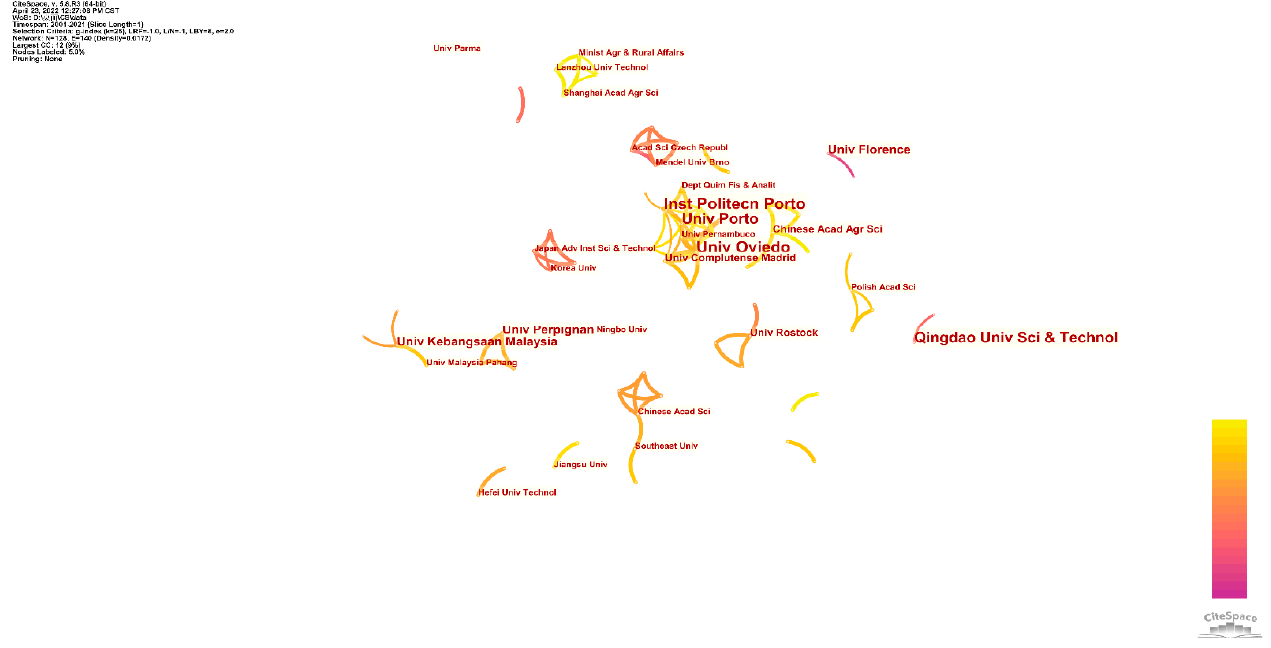
Figure 7. Institution cooperation network of published papers for electrochemical techniques for the detection and analysis of GM crops. detection and analysis of GM